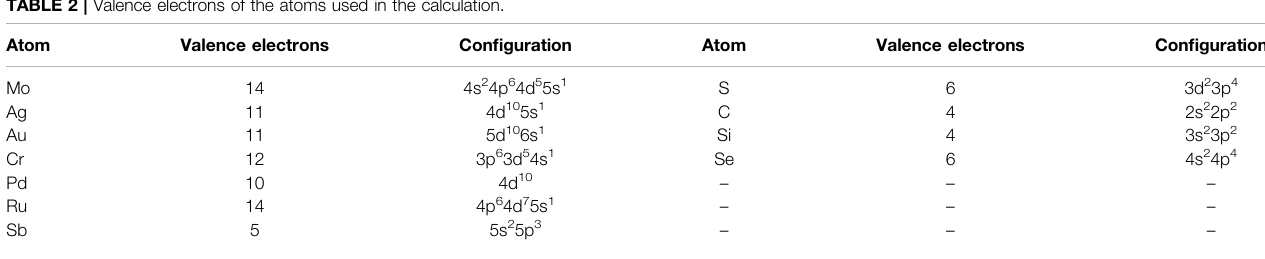
TABLE 2 | Valence electrons of the atoms used in the